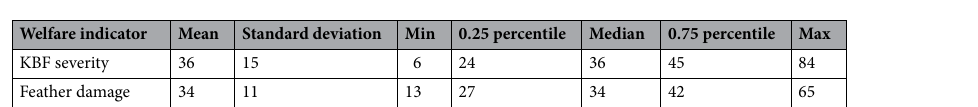
(cid:31)(cid:30) (cid:30) (cid:30)(cid:29) (cid:30) − observed prediction ). ( c ) Individual i i i ∈ day